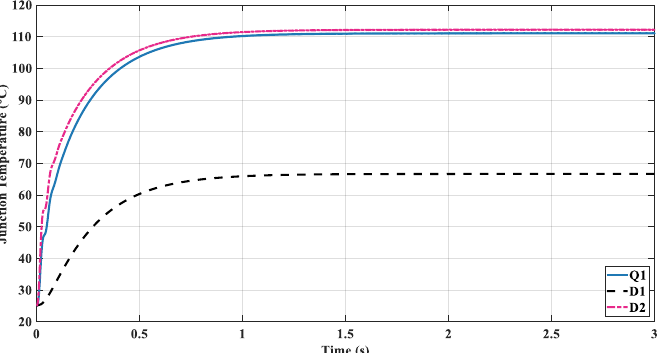
Figure 11. The junction temperature of the power semiconductors within the conventional boost converter.